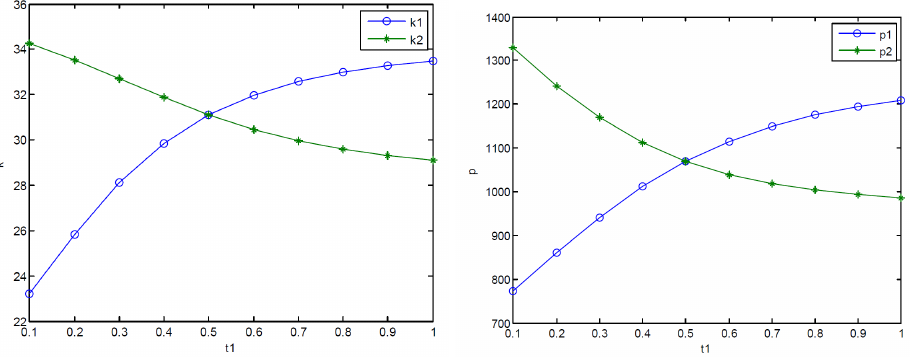
Figure 3. Effects of Efficiency Index on Capacities and